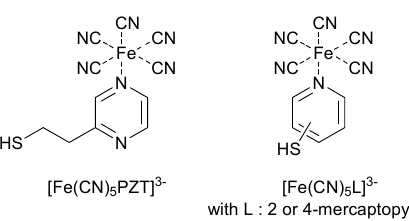
Scheme 18. Prussian blue-modified complexes.